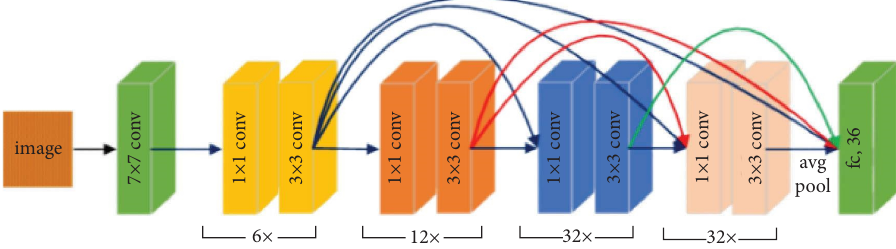
Figure 5: ResNet50